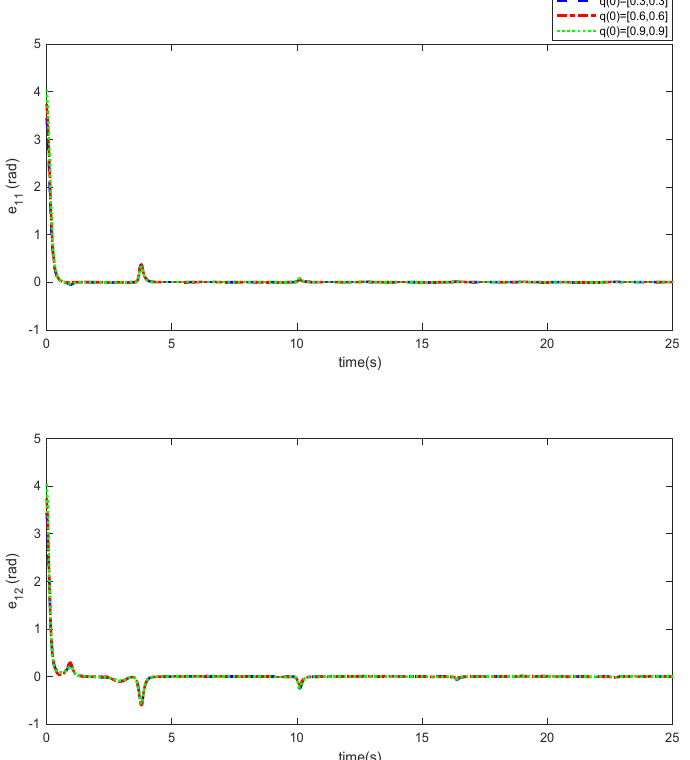
Figure 3. Trajectory of the tracking error based on Scenario 1.